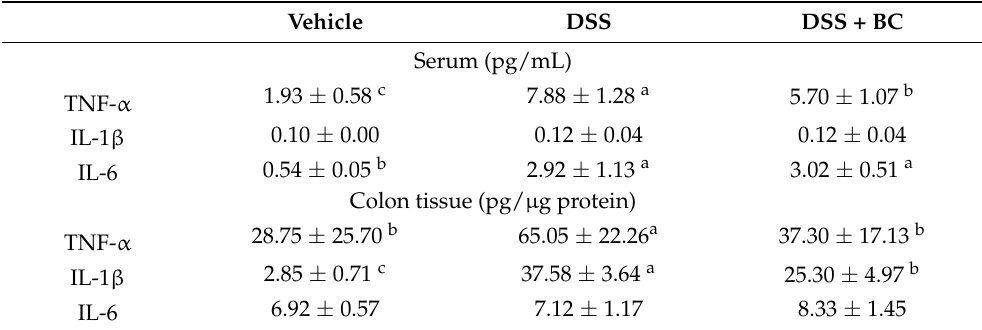
Table 1. Effects of blackcurrant on the levels of pro-inflammatory cytokines in serum and colon